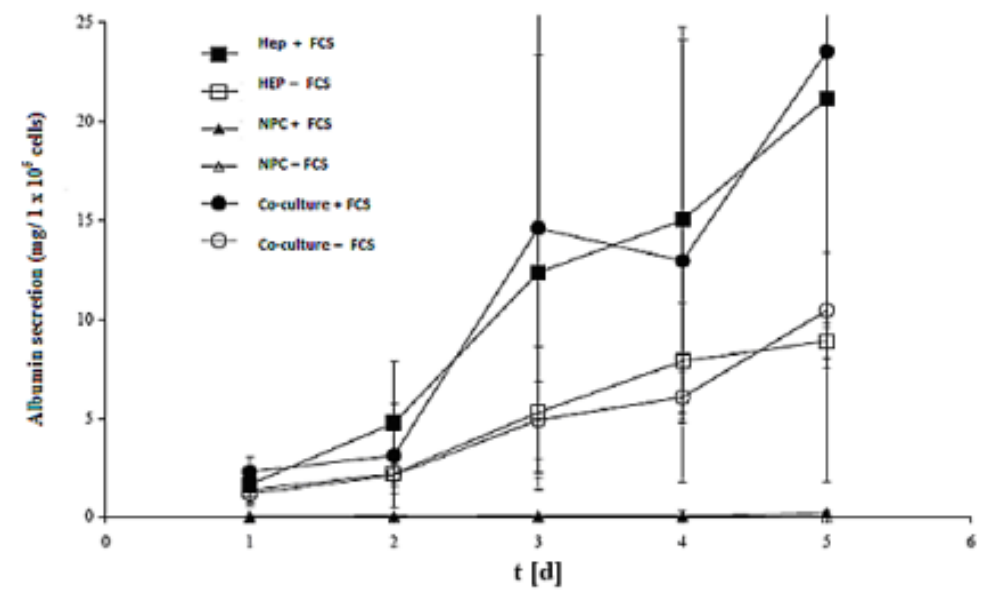
Figure 8. Albumin production in the sandwich and spheroid culture. (A) Total albumin production of the cells in serum-free and serum-containing mono-and co-cultures in the sandwich model; Hep + FCS, HEP – FCS, NPC + FCS, NPC – FCS, co-culture + FCS, co- culture – FCS. (B) Total albumin production of the cells in serum-free and serum- containing mono-and co-cultures in the spheroid model; Hep + FCS, HEP – FCS, co- culture + FCS, co-culture – FCS. Each point represents the mean ± S.E.M. of five experiments during which LDH activities were measured in